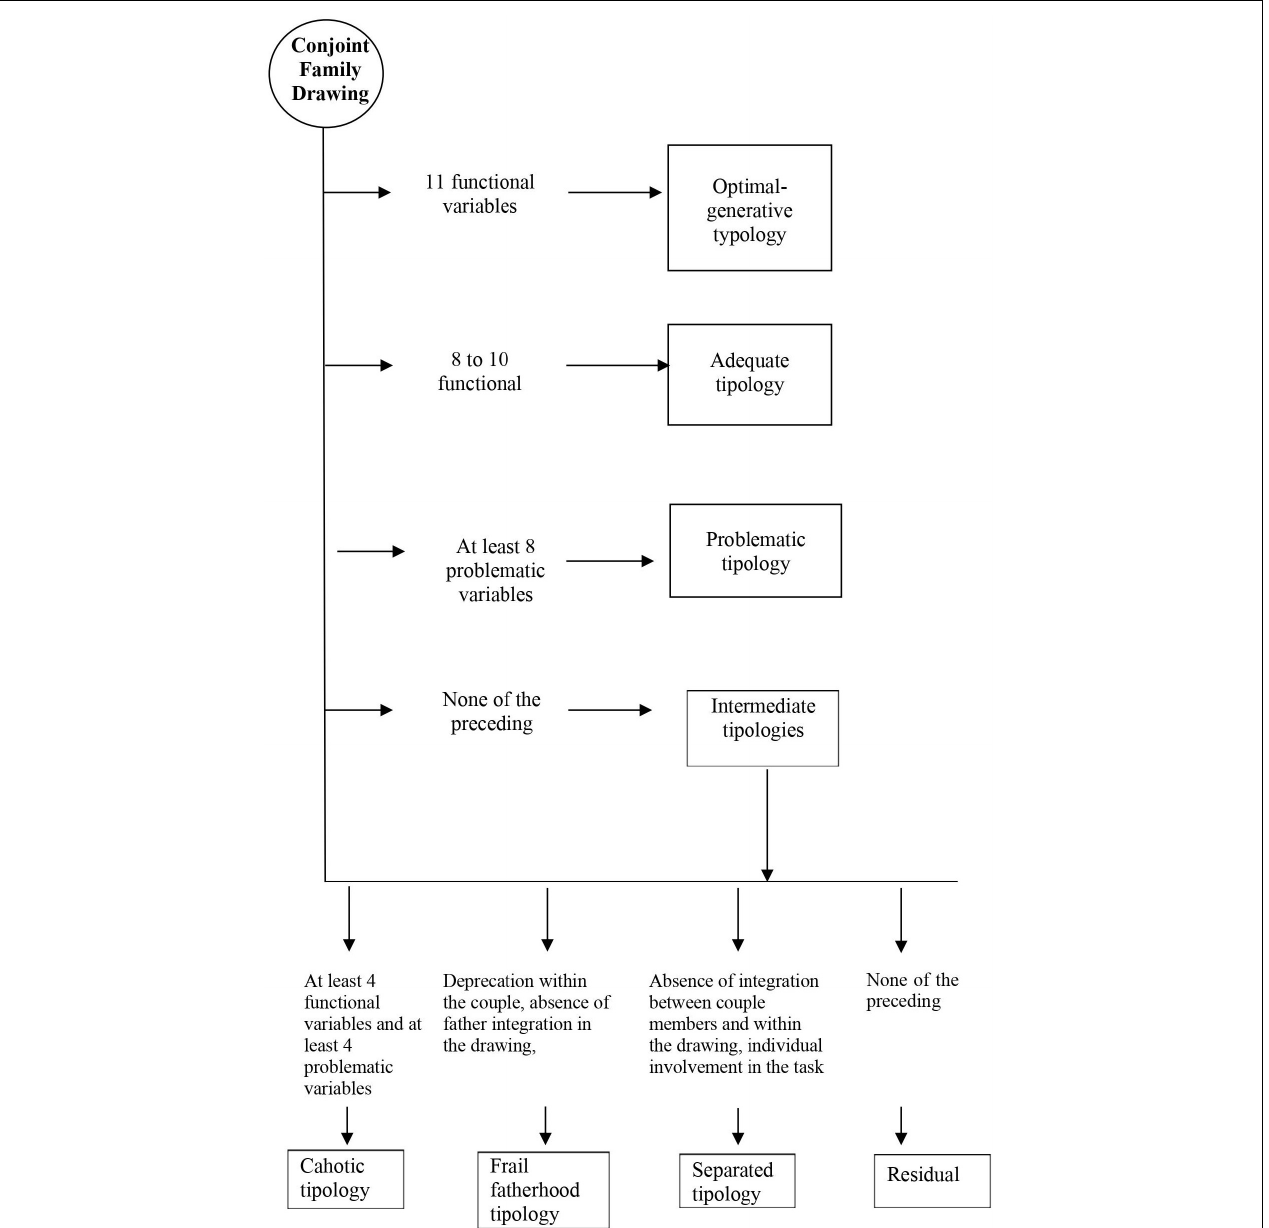
FIGURE 1 | Decision tree for the identification of family relational